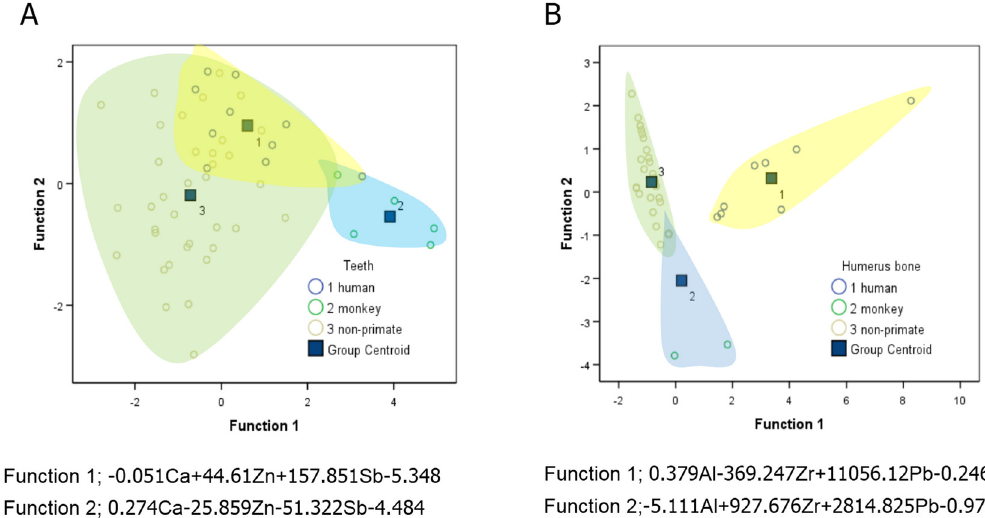
Fig 4. The feasibility of elemental composition in humerus bone for species classification. Canconical discriminant function plots of the elemental composition of humerus bone of different species (A) and the classification results by discriminant analysis expressed as a percentage of the correct prediction